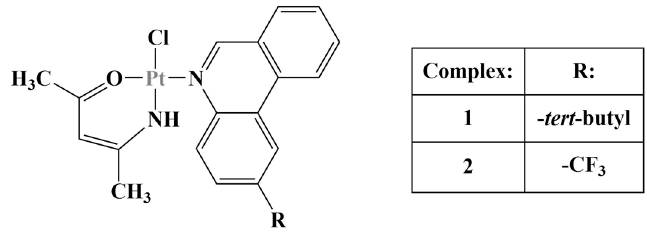
Figure 6. The complexes described in [30].